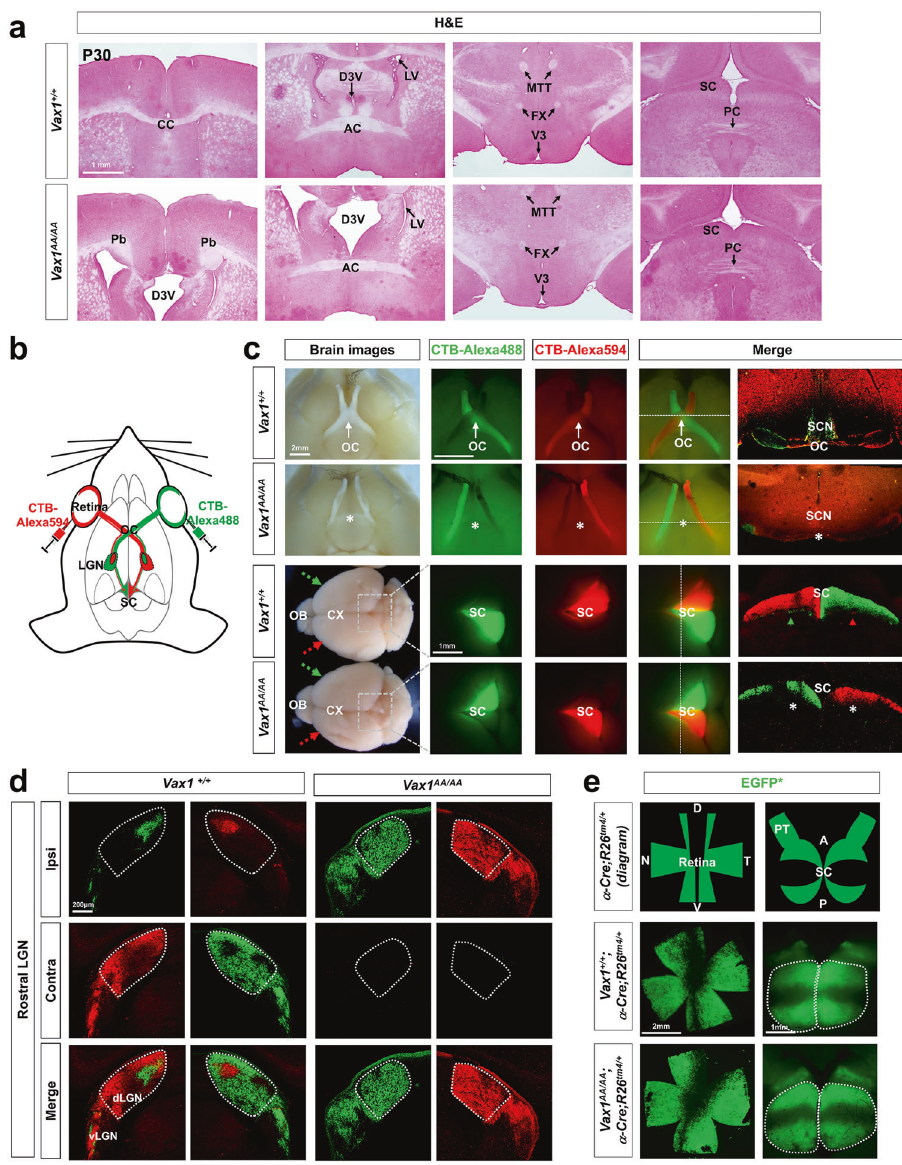
Fig. 6 Ipsilaterally biased RGC axon projection in Vax1 AA/AA mice. a Coronal sections of P30 mouse brains were stained with H&E. The sections containing the indicated commissural structures were identi fi ed and shown. AC, anterior commissure; CC, corpus callosum; D3V, dorsal third ventricle; FX, fornix; Pb, probus bundle; PC, posterior commissure; SC, superior colliculus; MTT, mammillo-thalamic tract. b Diagram depicting the fl uorescence labeling of mouse RGCs. ( c ) Alexa 488- and Alexa 594-labeled CTB proteins were injected into the right and left eyes of the mice at P28, respectively. Brains of the CTB-injected mice were isolated at P30, and fl uorescent signals emitted from the brains were visualized by an Axio Zoom stereoscope (Zeiss; three center columns). Then, the fl uorescent signals in coronal sections of the brains were detected by an FV1000 confocal microscope (Olympus; rightmost column). Bright- fi eld images of the brains were also taken to show the structure of the brains and optic nerves (leftmost column). CX, cerebral cortex; OB, olfactory bulb; *, ventral midline of HT equivalent to the position of the OC in Vax1 + / + littermates. d Coronal sections of the CTB-injected mouse brains were collected, and fl uorescent signals in the LGN area were detected. The areas surrounded by dotted lines are the dLGN. Contra, contralateral LGN section; Ipsi, ipsilateral LGN section. e The retinas and brains of P30 Vax1 + / + and Vax1 AA/AA littermate mice carrying α - Cre ; R26 tm4/ + transgenes, which express membrane-targeted EGFP (EGFP*) at the R26 tm4 gene locus upon Cre-dependent excision of the loxP-tdTomato*-loxP gene cassette, were isolated and visualized. The areas surrounded by dotted lines are SC. PT,